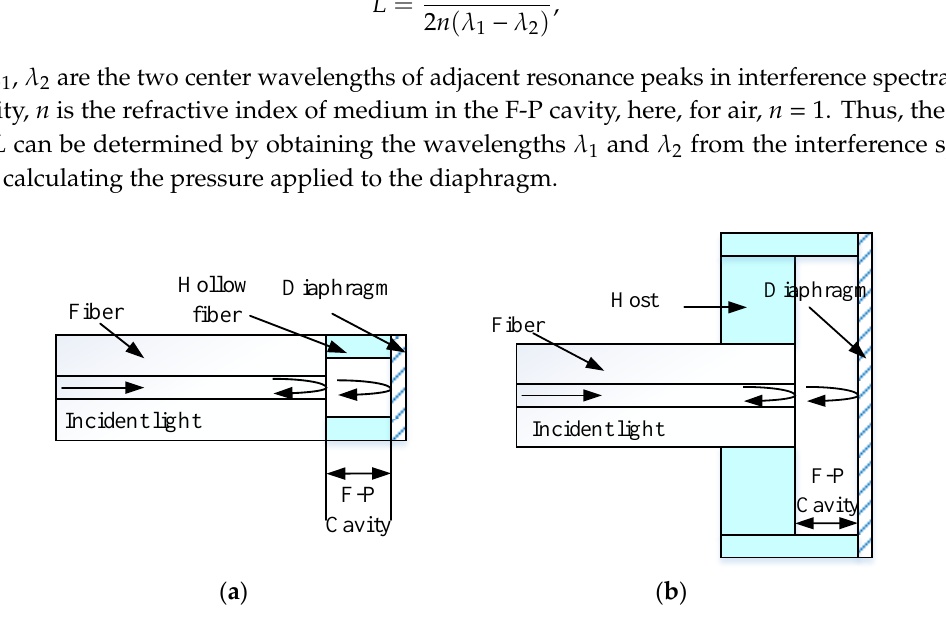
Figure 1. The typical structure of a diaphragm-based extrinsic Fabry-Perot interferometer (EFPI) fiber-optic pressure sensor. ( a ) Fiber-tip structure; ( b ) Fiber-end